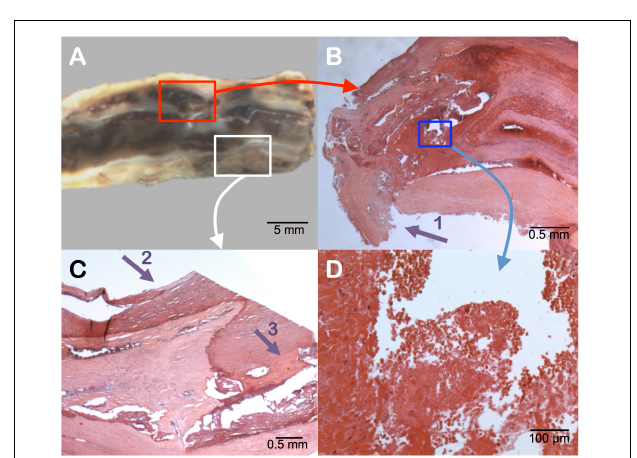
FIGURE 2 | Pathology examination of the carotid plaque. Gross longitudinal section (A) . Presence of an intraplaque hemorrhage (surrounded by the red box) in the upper section, as seen in cross-sectional microscopic analysis (B) . Identification of the rupture zone of the fibrous cap (arrow 1). At higher magnification of the blue box (D) the intraplaque hemorrhage contains numerous red blood cells with intact membranes, confirming a recent hemorrhage. The posterior part of the plaque (white box) shows surface calcifications (arrow 2) and deep calcifications (arrow 3) (C)